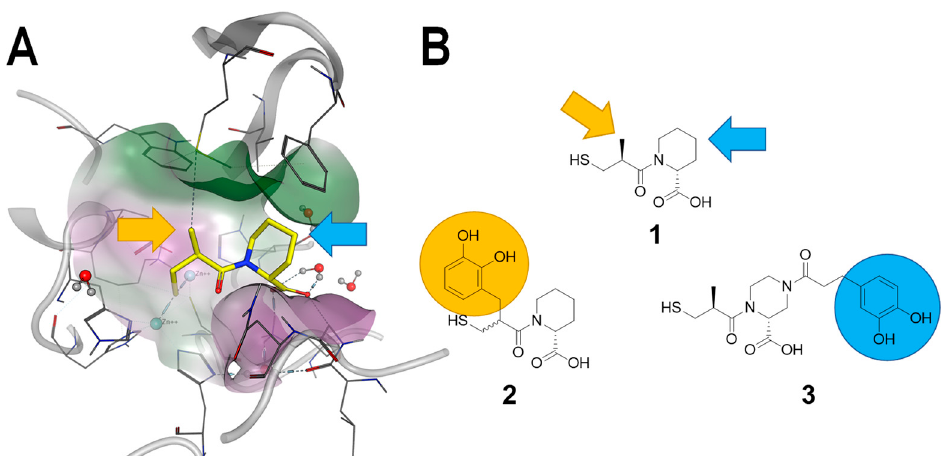
Figure 2. Design strategy of siderophore-containing MBL inhibitors. ( A ). X-ray structure of NDM-1 in complex with compound 1 (PDB code 6LJ0). Yellow and blue arrows indicate the positions which are sterically and chemically accessible for introduction of larger moieties. ( B ). Yellow and blue arrows indicate chemically tractable positions to introduce catechol moieties in compound 1 , which results in the design of compounds 2 and 3 .